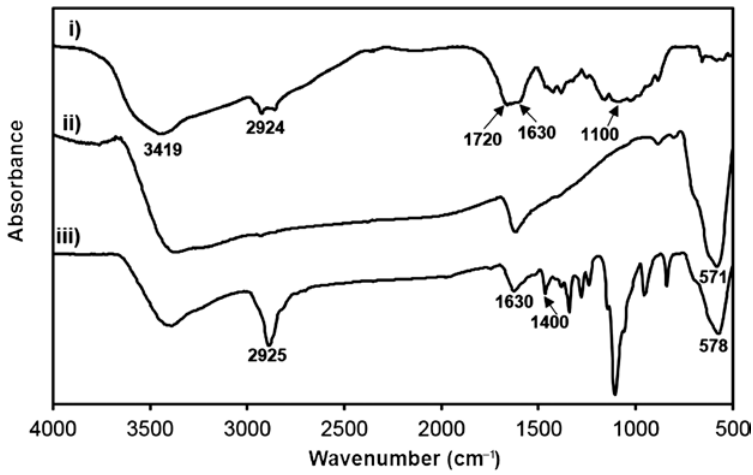
O MNPs, and (iii) Fe 3 4